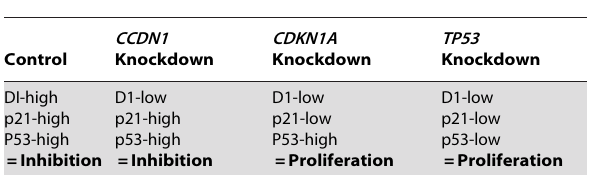
Figure 5. Cyclin D1 is not required for p14ARF-induced cell growth (size, [forward scatter; FSC-A]). MCF7 cells were transfected in triplicate with siRNA as described in Figure 4, and cells were harvested at day 3 and analysed using a BD LSRII cytometer. Flow cytometry data (20,000 events) were acquired using DIVA software (version 6.1.3), analysed with CellQuest Pro (version 6) and composite figures were generated with CANVAS (version X) software. A. To eliminate cell doublets and clumps from the analysis, single cells were gated (R1) from FSC-A versus FCS-H dot plots. A representative plot only is shown from mock-transfected cells. FSC-A histograms of the R1 populations were then used to indicate relative cell size of MCF-7 cells 6 IPTG treatment after siRNA knockdown of cyclin D1, p53 and p21. Black line shows cells without IPTG and the red line shows cells treated with IPTG. B. Mean Fluorescent Intensity (MFI) analysis of FSC-A from triplicate biological experiments; data shown are mean MFI 6 SD. C. Cell counts were performed using a haemocytometer. Data were presented as mean cell counts (x10 4 ) 6 SD performed on three separate occasions.